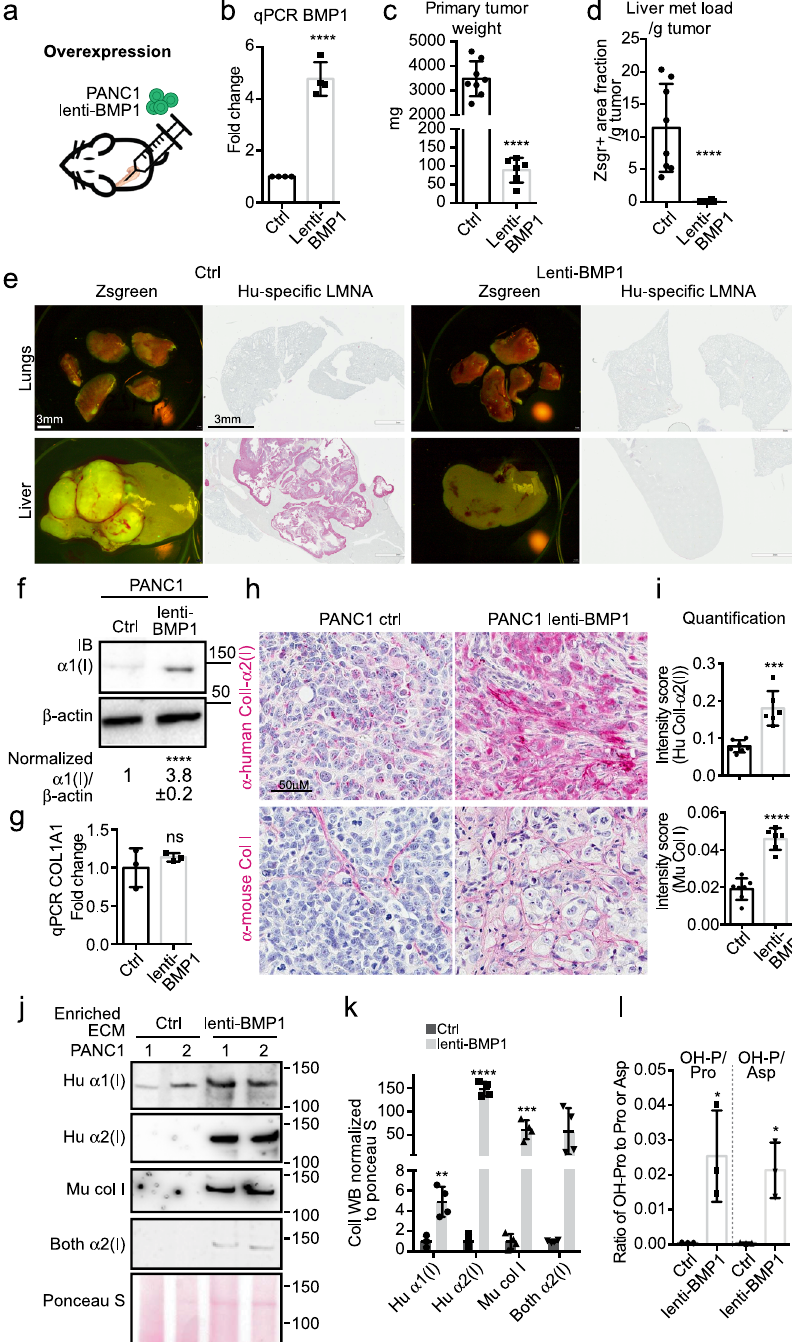
Fig. 4 Overexpressing BMP1 in PANC1 cells suppresses tumor growth and metastasis. a – e Orthotopic injection of PANC1 cells ( a ) overexpressing BMP1 with lenti-BMP1 ( b ) resulted in reduced primary tumor weight ( c ), and reduced liver metastasis load after normalization to primary tumor weight ( d ). Representative lung and liver metastasis images are shown in e with both zsgreen signal and human LMNA IHC to highlight cancer cells. Note that PANC1 cells are not metastatic to the lungs. Mouse numbers are 8 and 6 (left to right). f , g Cultured lenti-BMP1 PANC1 cells deposit 4x more α 1(I) compared to control cells ( f ) although COL1A1 RNA level is comparable ( g ). f Shows images representative of three independent experiments with β -actin as a sample processing control. The quanti fi ed WB signal is represented as mean ± SD. h , i IHC on xenograft tumor sections showed increased intensities in both cancer-cell- and stromal-derived ColI staining upon BMP1 overexpression in the PANC1 cells ( h ). The intensities were quanti fi ed in i ( N = 7 and 6, left to right). j , k WB on enriched ECM samples from xenograft PANC1 tumors showed increased cancer-cell-derived (human) and stromal-derived (mouse) ColI deposition in lenti-BMP1 tumors. See Methods section for antibodies used. k is the quanti fi cation of the band intensities of four tumors (two were shown in j and two came from an independent repeat). l The normalized intensity of protein Hypro to either protein proline or aspartic acid in xenograft tumors suggested an increase in overall collagen upon BMP1 overexpression in PANC1 cells ( N = 3). All p -values come from two-tailed Student ’ s t tests. All columns are represented by mean ±